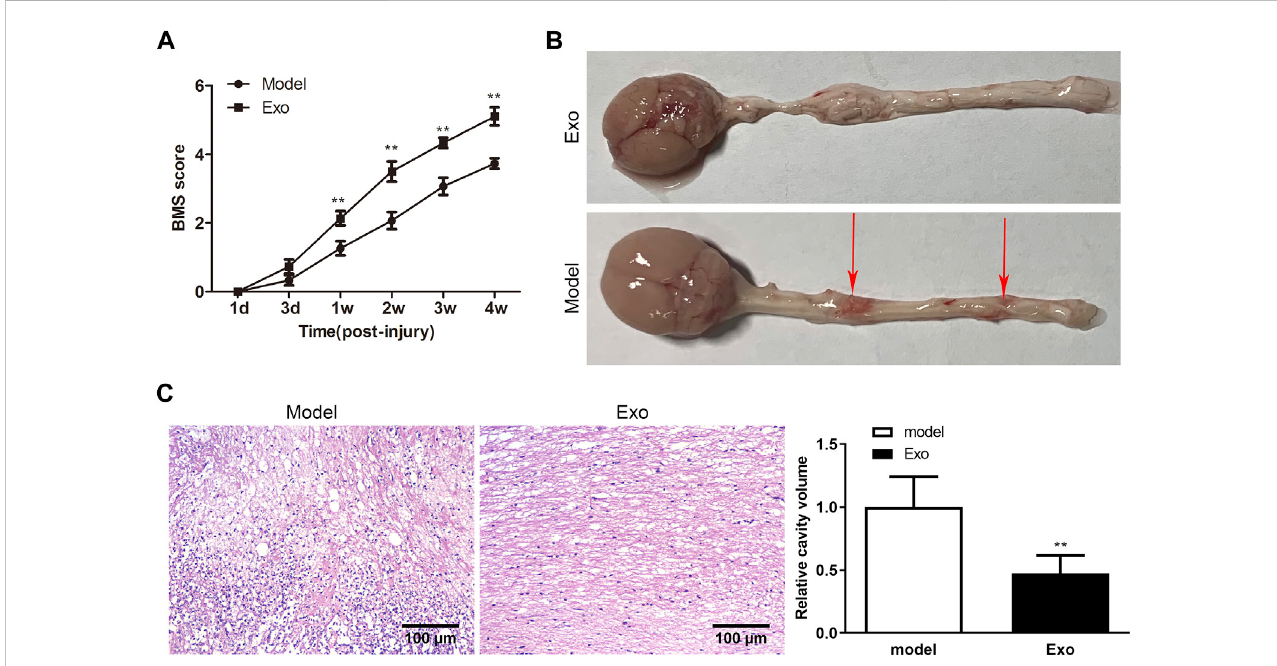
FIGURE 2 IPSCs-Exo improved motor function in SCI mice. (A) BMS scores. ** p < .01 vs. the model group. (B) The overall shape of the spinal cord was observed in SCI model mice. The red arrow indicated the point of injured spinal cords in SCI model mice. (C) H&E staining of longitudinal SCI sections at 4 weeks. Scale bar = 100 μ